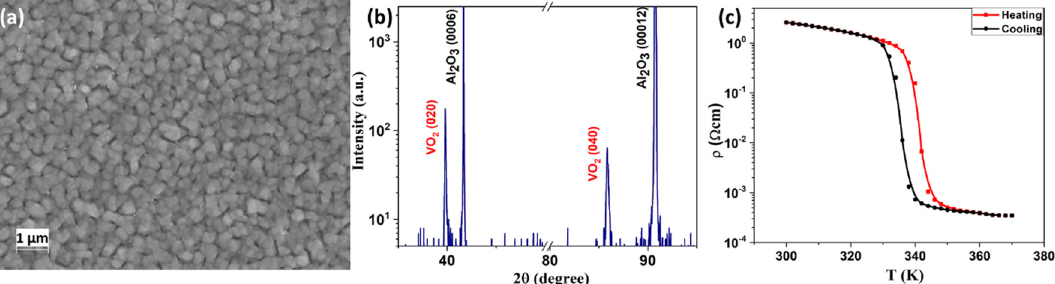
Figure 1. ( a ) SEM image and ( b ) XRD θ -2 θ measurement of VO 2 thin films grown on c-cut sapphire substrate. ( c ) Temperature-dependent resistivity showing the IMT of VO 2